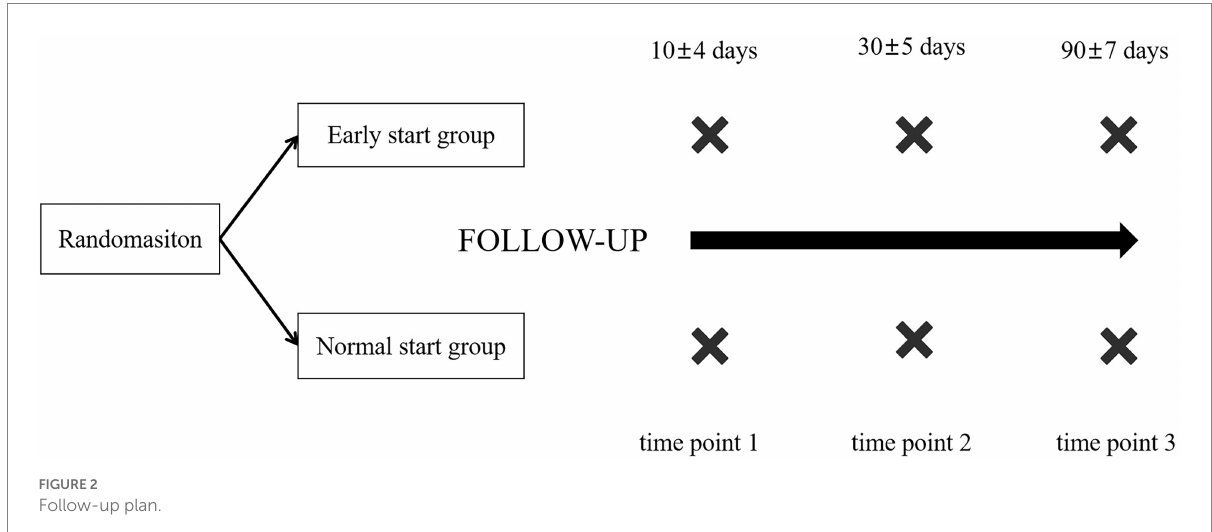
FIGURE 2 Follow-up